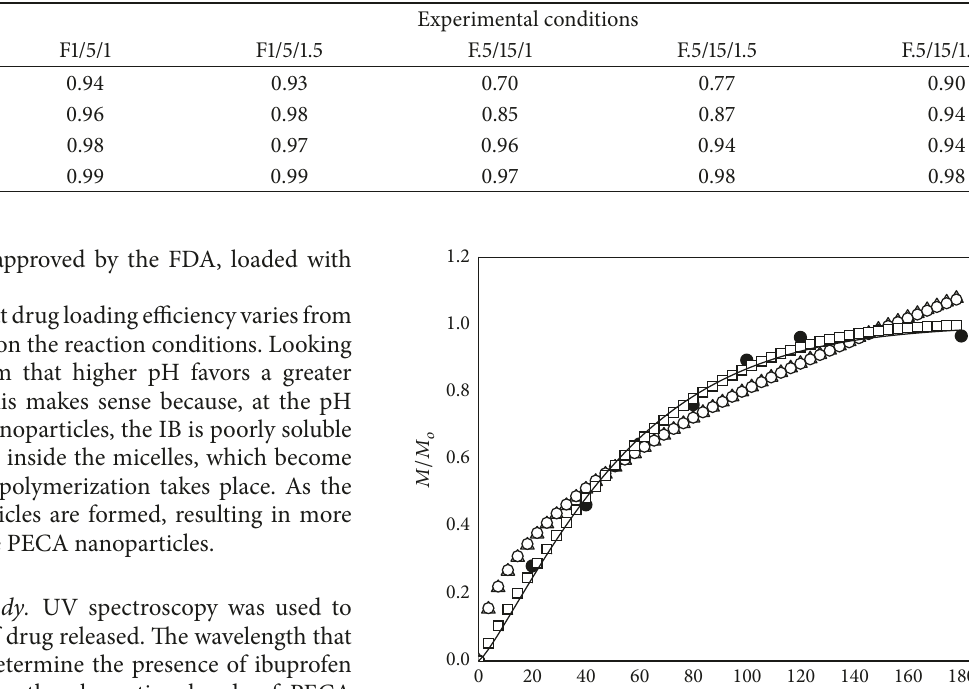
Table 2: 𝑅 2 values for the drug release models used to fit the experimental data.